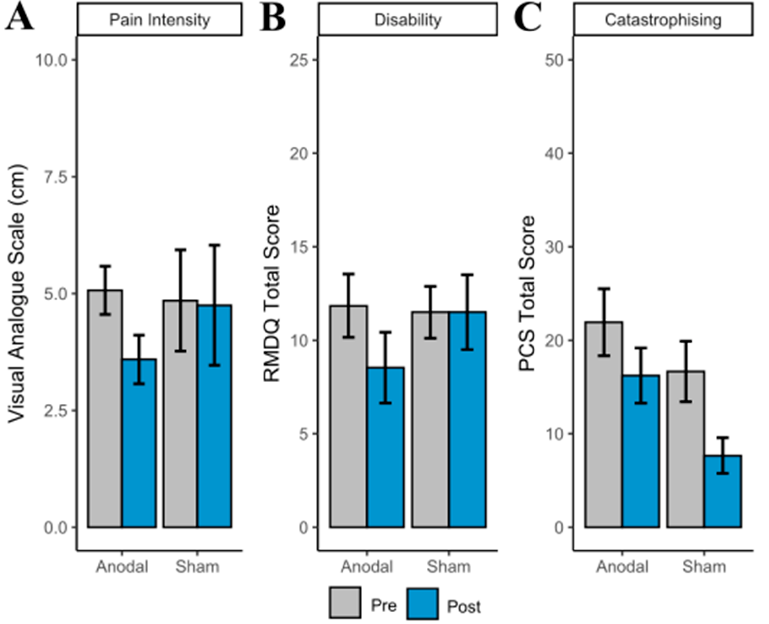
Figure 4. ( A ) Pain intensity, ( B ) Roland Morris Disability Questionnaire (RMDQ), and ( C ) Pain Catastrophising Scale (PCS) total scores (with standard error of the mean error bars) at pre- and post-intervention by group.